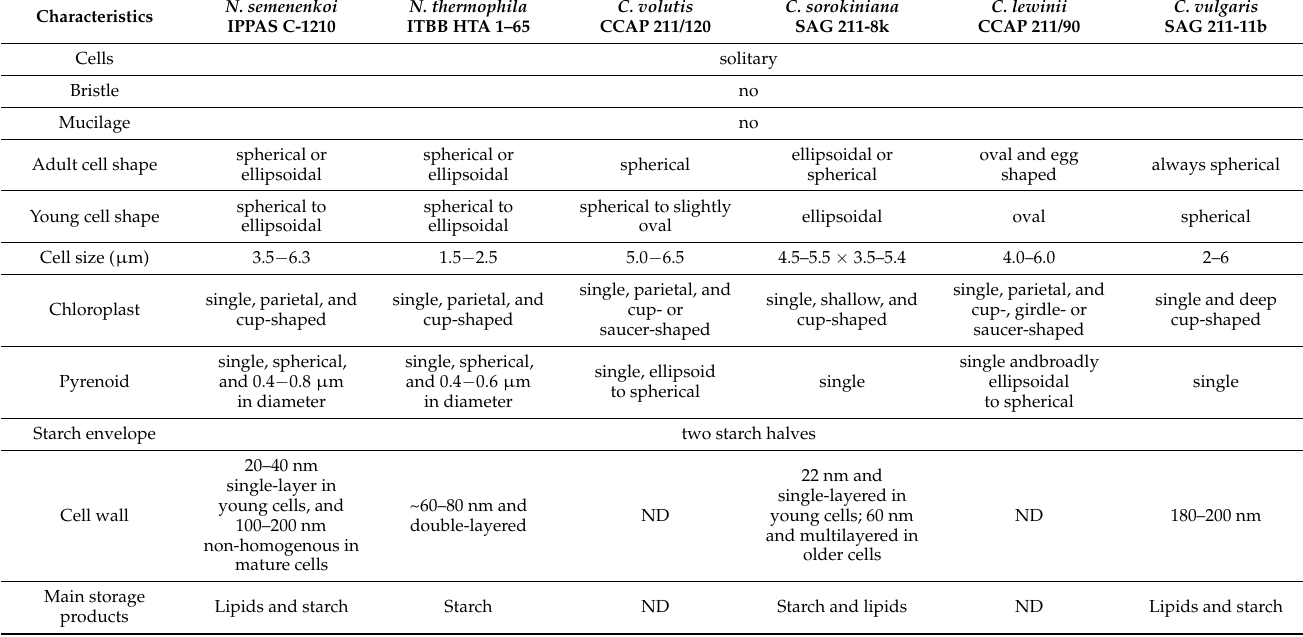
Table 3. Comparative characteristics of some Chlorella clade